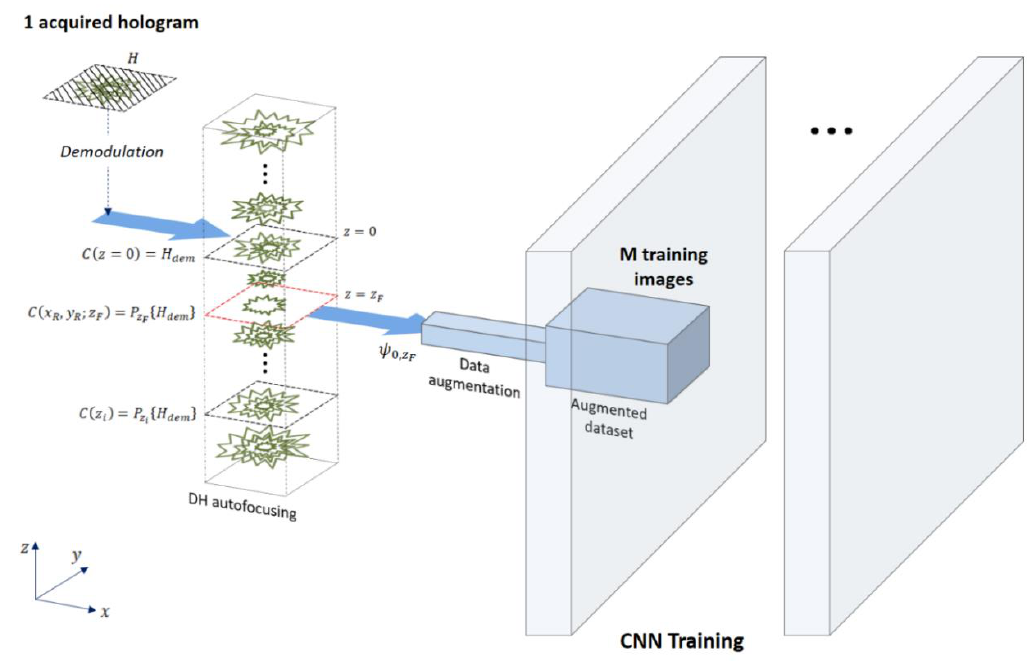
Figure 2. Augmentation of Holographic data provides 174.636 phase-contrast images from one single hologram of the object.